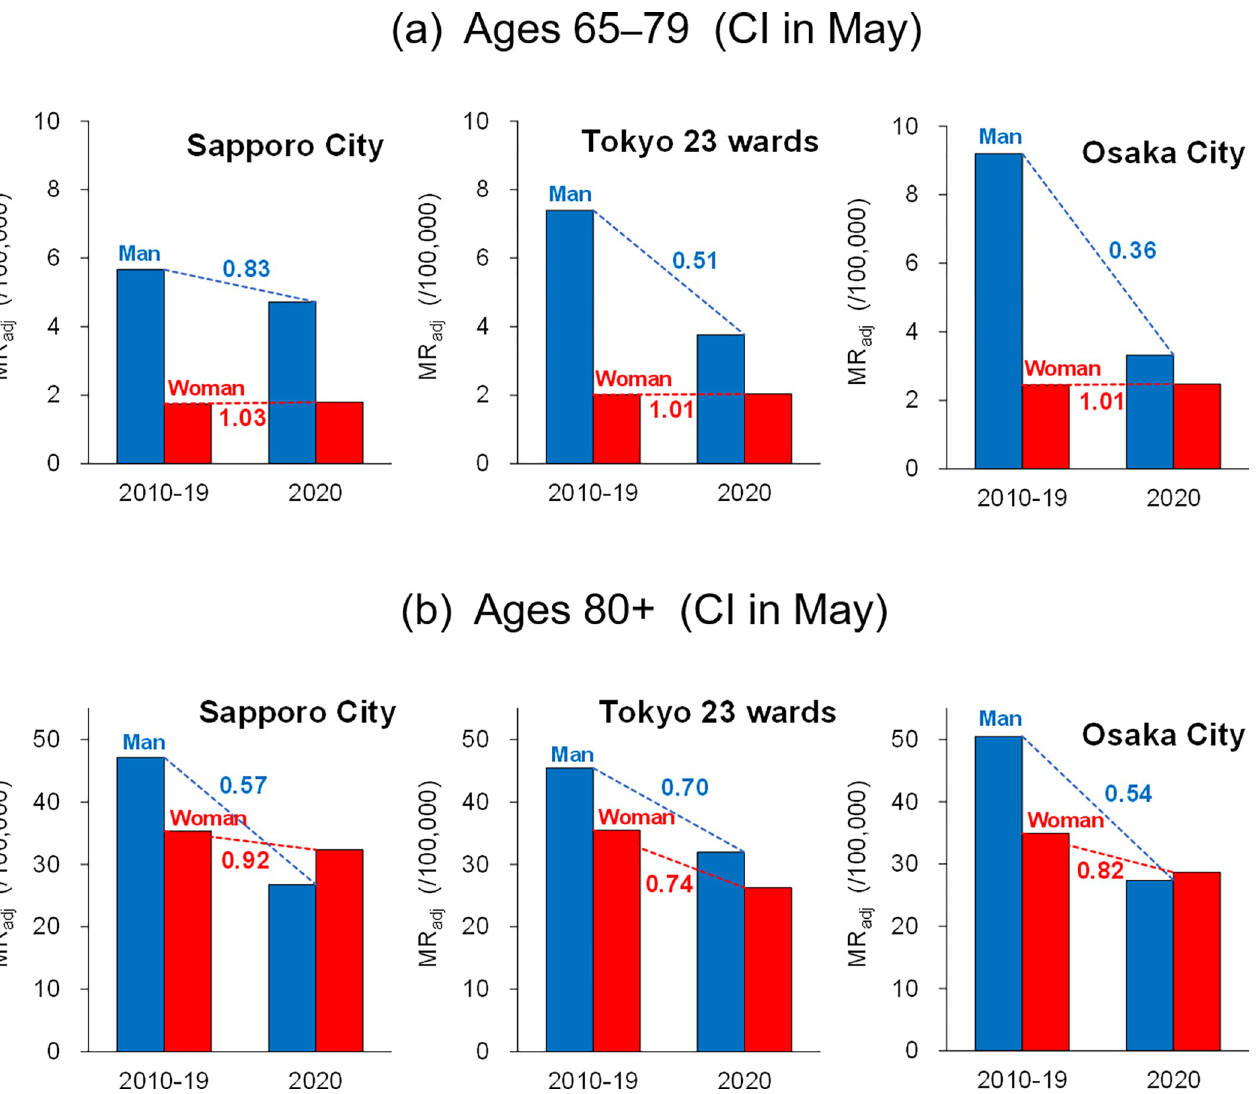
Fig 9. Comparison of the cerebral infarction (CI) MR adj in older men and women between 2010–2019 and 2020. The results of (a) 65–79 age group and (b) 80 and older age group are displayed for May, in which temperature-sensitive CI was found in all cities. Numerals for men and women are the ratio of the 2020 MR adj to the 2010–2019 averaged MR adj